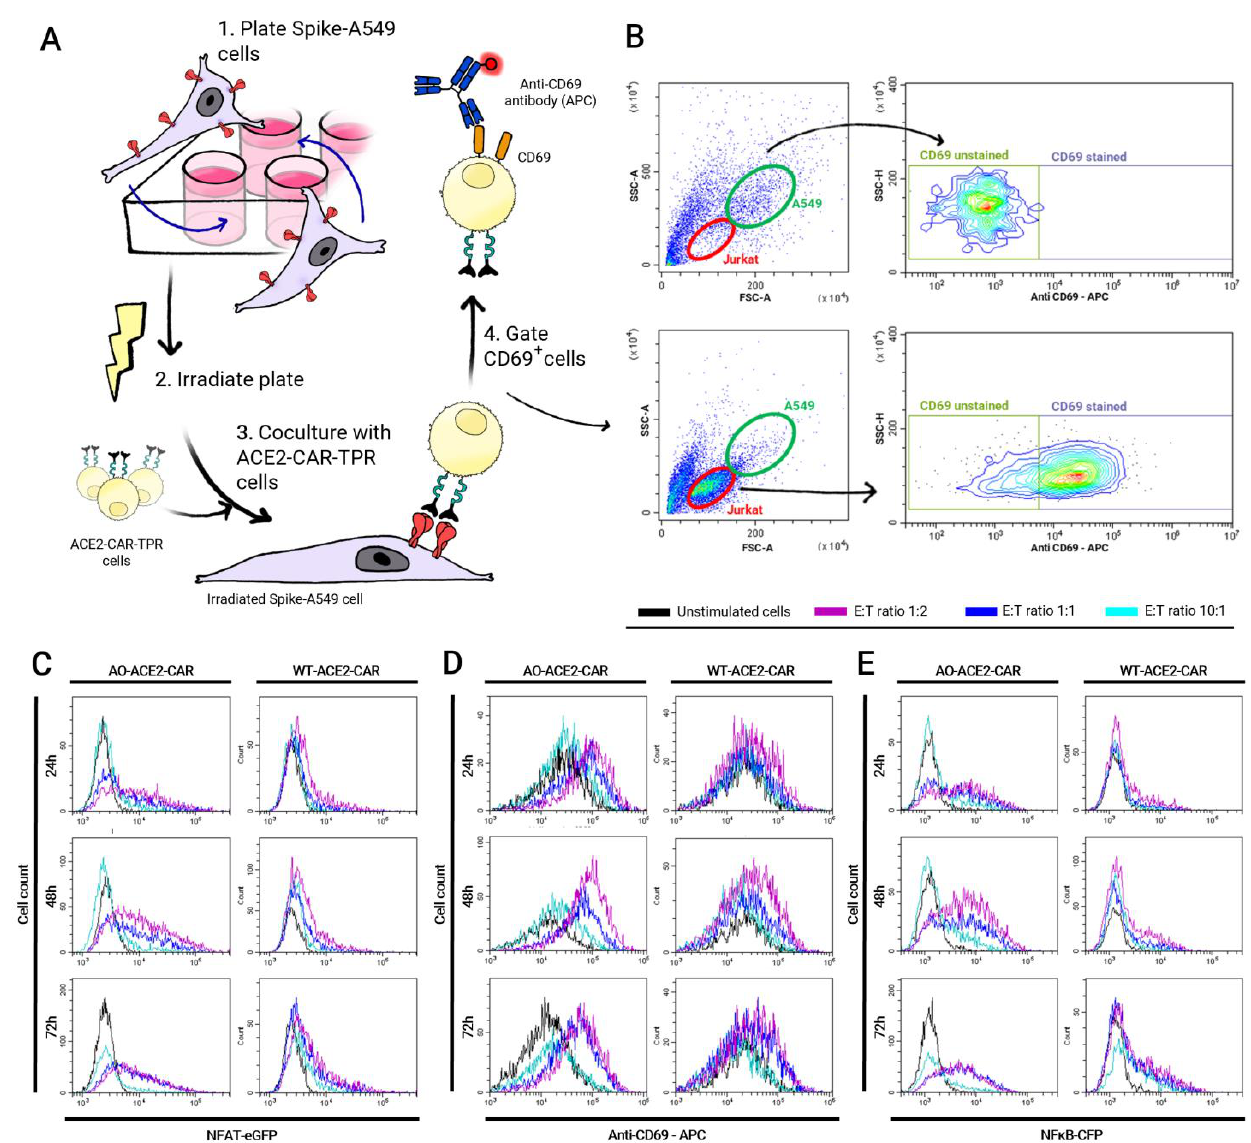
Figure 6. Jurkat-A549 co-culture assay. Schematic representation of the procedure ( A ) and illustration of FACS gating strategy ( B ), which allowed Jurkat (below) to be distinguished from A549 cells (above) based on FSC and SSC as well as on CD69 staining expressed in Jurkat over A549 even in the absence of stimulation. ( C – E ) Histogram overlays showing eGFP (NFAT), CFP (NF κ B) or CD69 upregulation 24, 48 and 72 h after co-culturing with A549-Spike target cells at 1:1 effector:target ratios, at different time points. A representative experiment out of three performed in triplicate is shown.